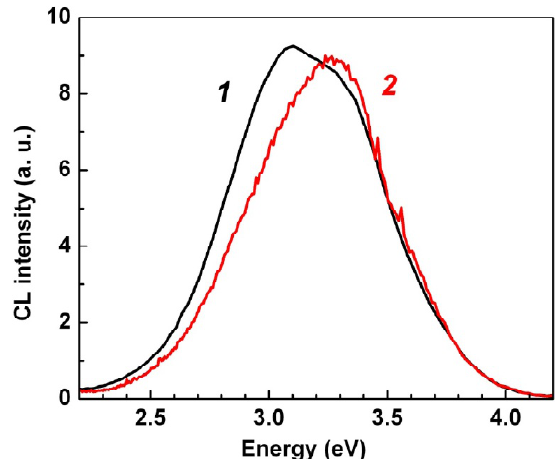
Fig. 2. Examples of CL spectra registered from (010) plane (curve 1 ) and (100) plane (curve 2 ) of Ga samples.